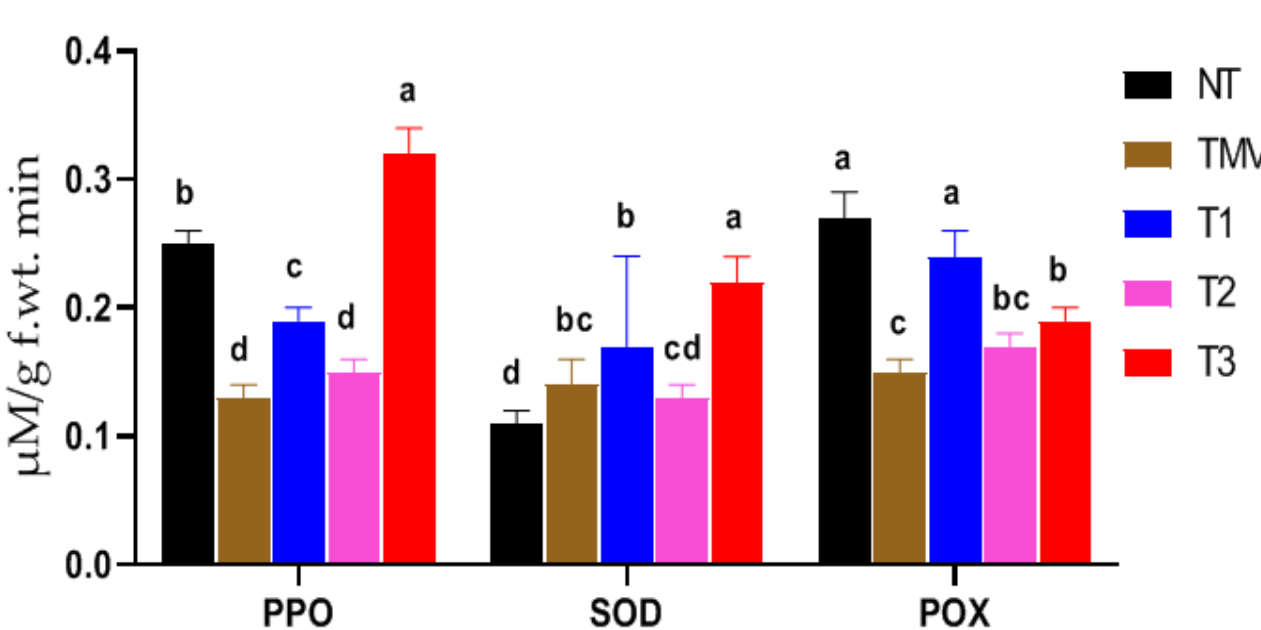
Figure 4. Effect of foliar application of B. subtilis strain HA1-culture filtrate on activities of antioxidant enzymes PPO, SOD, and POX of tomato plants at 22 days post-TMV inoculation. NT: mock plants; TMV: virus-infected plants; T1: tomato plants sprayed with bacterial culture filtrate 24 h before viral infection; T2: tomato plants sprayed with bacterial culture filtrate after 24 h of viral infection; T3: tomato plants sprayed with bacterial culture filtrate two times, 24 h before and 24 h after the viral inoculation. Each column value represents the mean result obtained from five biological replicates. Significant differences were calculated using a one-way ANOVA according to the least significant difference (LSD) method at a p ≤ 0.05 level of probability with the GraphPad Prism software package. The mean values of each column with the same letter do not differ significantly.